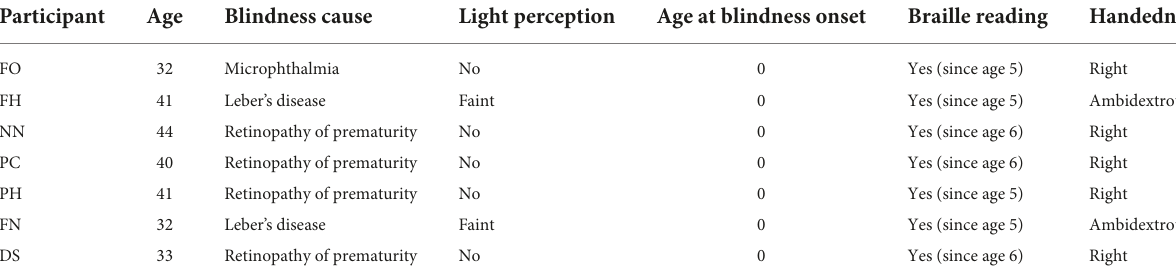
TABLE 1 Participants’ demographic